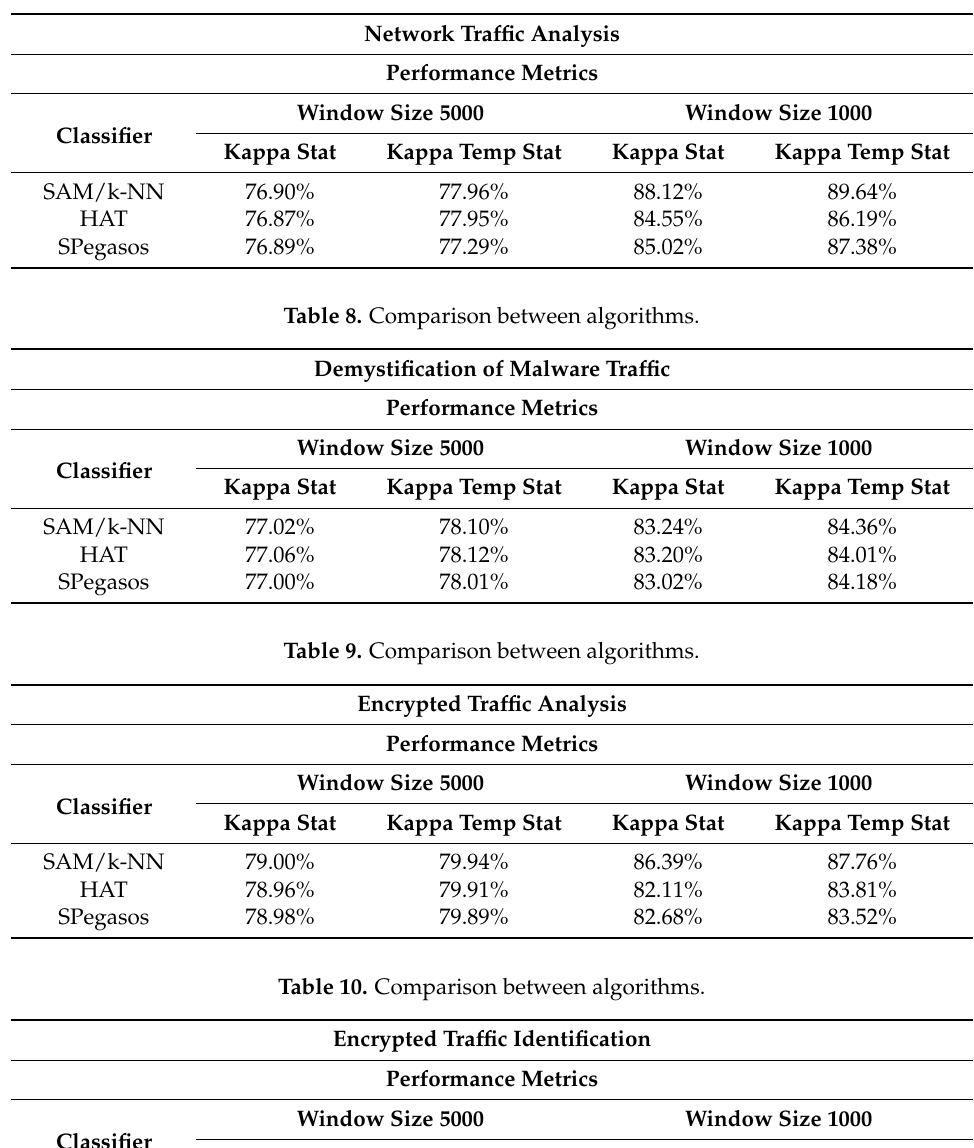
Table 7. Comparison between algorithms.